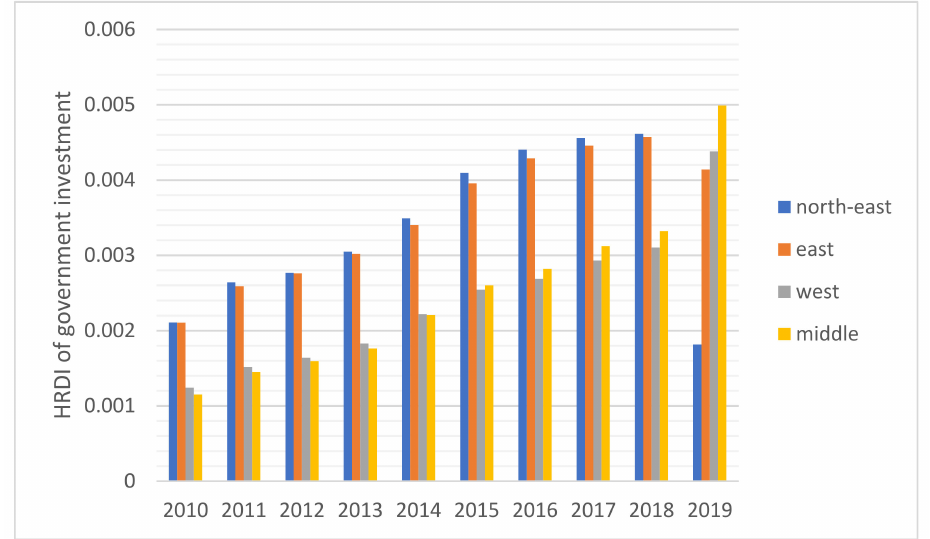
Figure 1. The HRDI of the health resources in investment when dividing China into four areas.